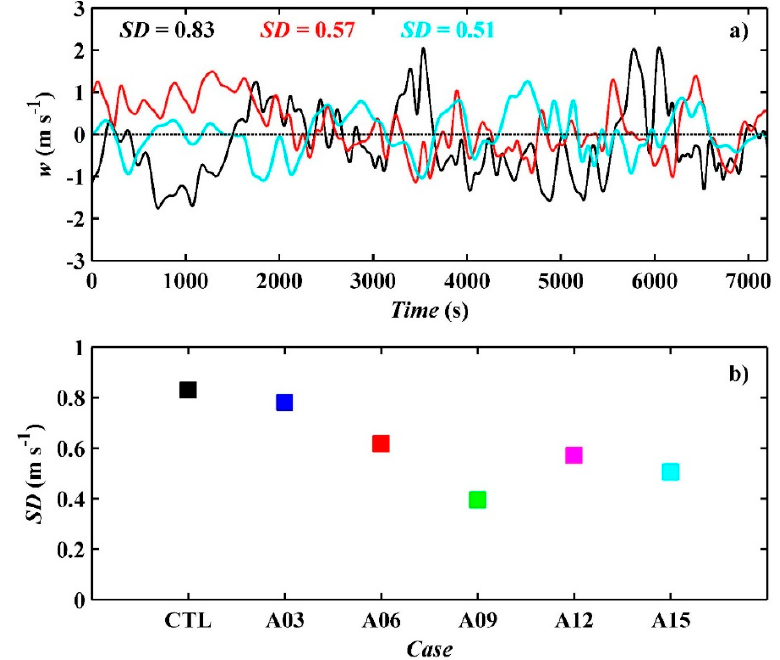
Figure 3. ( a ) Time series of instantaneous vertical velocity at the central point of the large-eddy simulation (LES) domain, and ( b ) standard deviation (SD) for different cases. Black: control case (CTL), AOD = 0; blue: aerosol case (A03), AOD = 0.3; red: aerosol case (A06), AOD = 0.6; green: aerosol case (A09), AOD = 0.9; magenta: aerosol case (A12), AOD = 1.2; cyan: aerosol case (A15), AOD = 1.5.